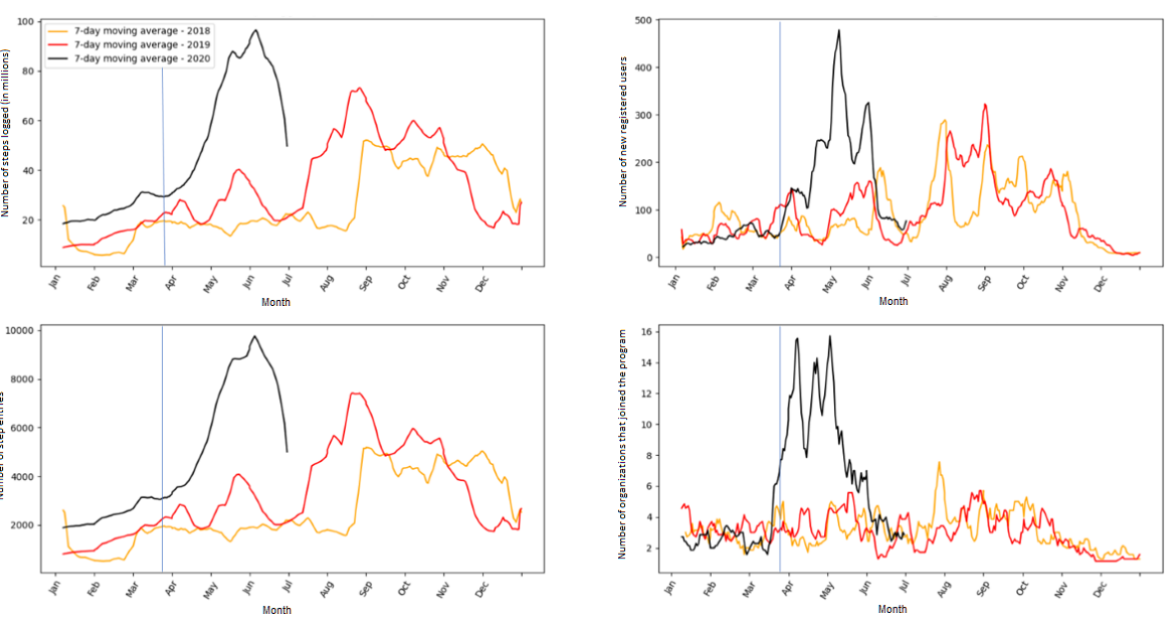
Step average of 30 daysStep average of 7 daysState